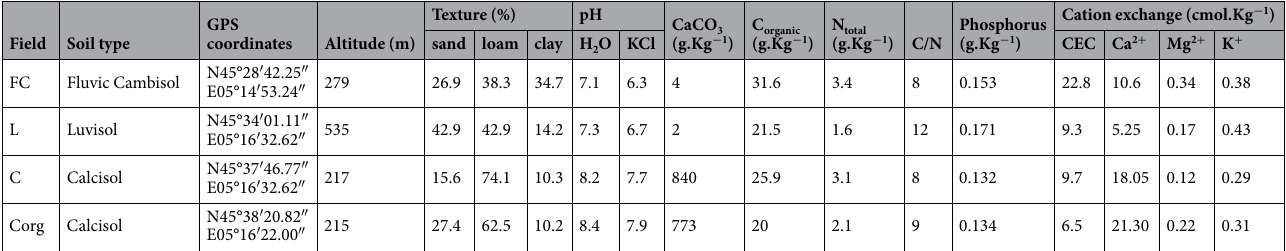
Table 1. Field characteristics of the top (5–30 cm) soil layer. CEC: cation exchange